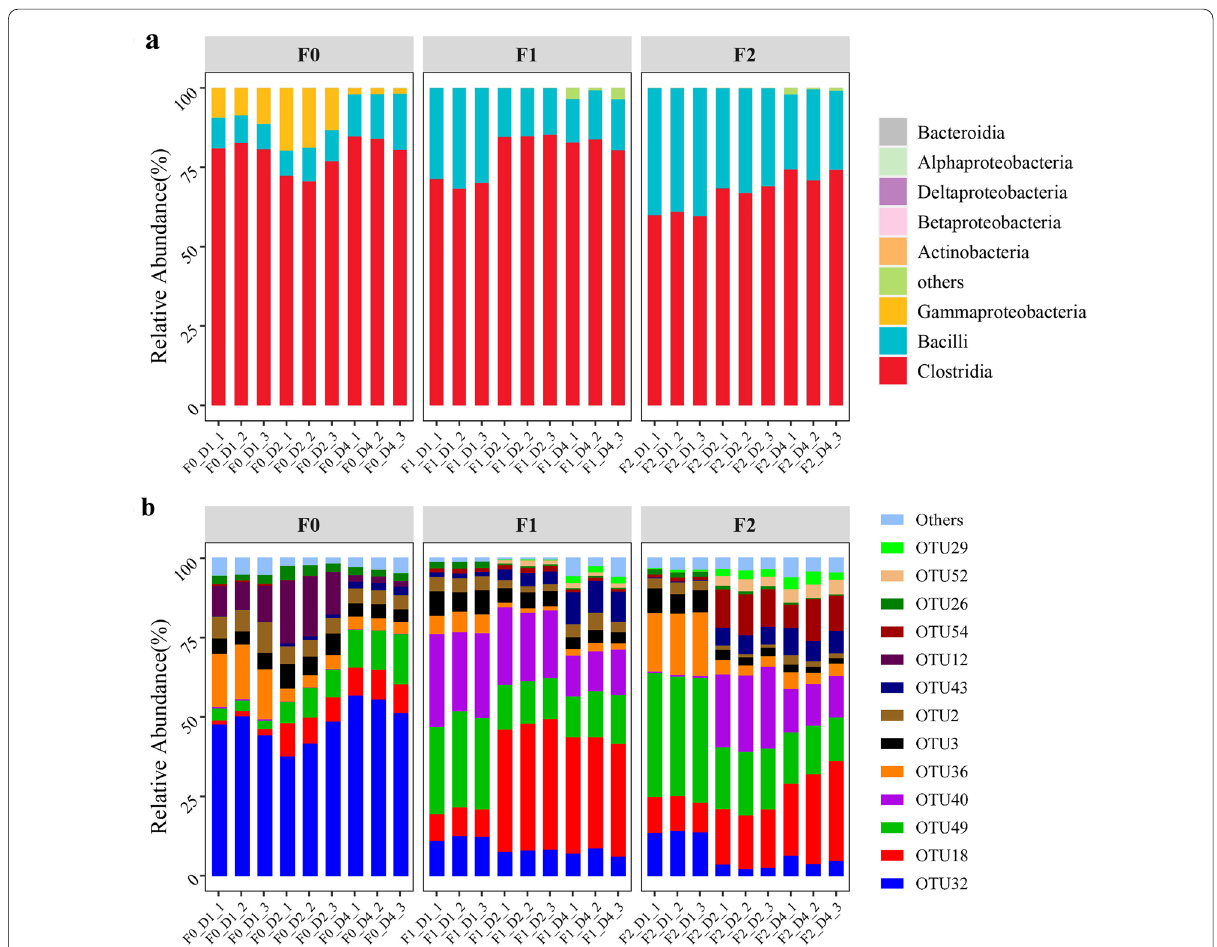
Fig. 5 Succession of the microbial community at A class level and B OTU level during